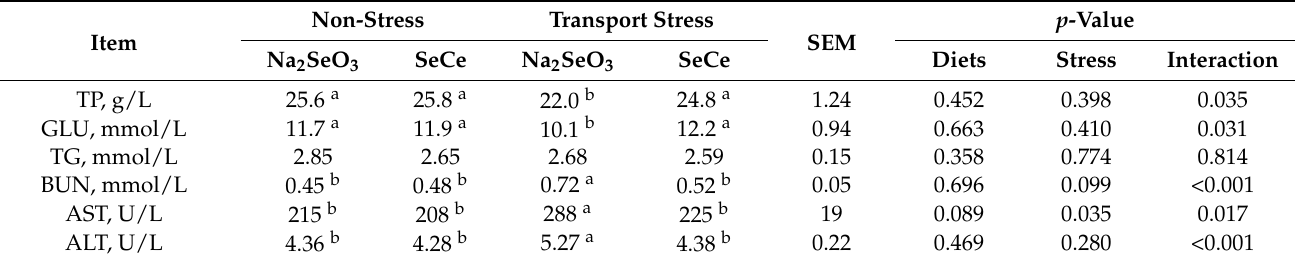
Table 3. Effects of dietary Se-enriched Cardamine enshiensis supplementation on plasma biochemical parameters of broilers under transport stress 1 .